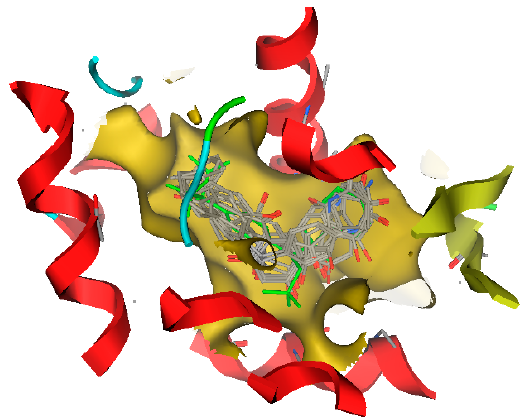
Figure 1. The best-docked conformations and poses of 10 new screened ABCA1 up-regulators in the ligand binding domain of LXR β : the original ligand of X-ray crystal structure was depicted in green stick mode, newly-screened ABCA1 up-regulators were depicted in gray stick mode. Molecules 2016 , 21 , 1639